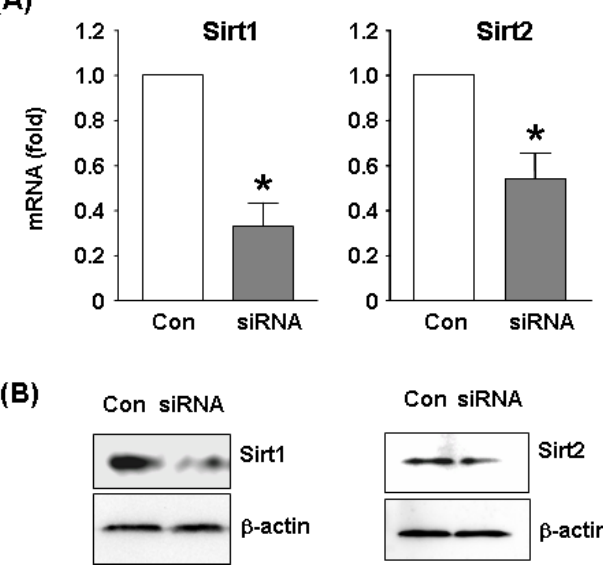
O -treated HUVECs. A non-specific 2 2